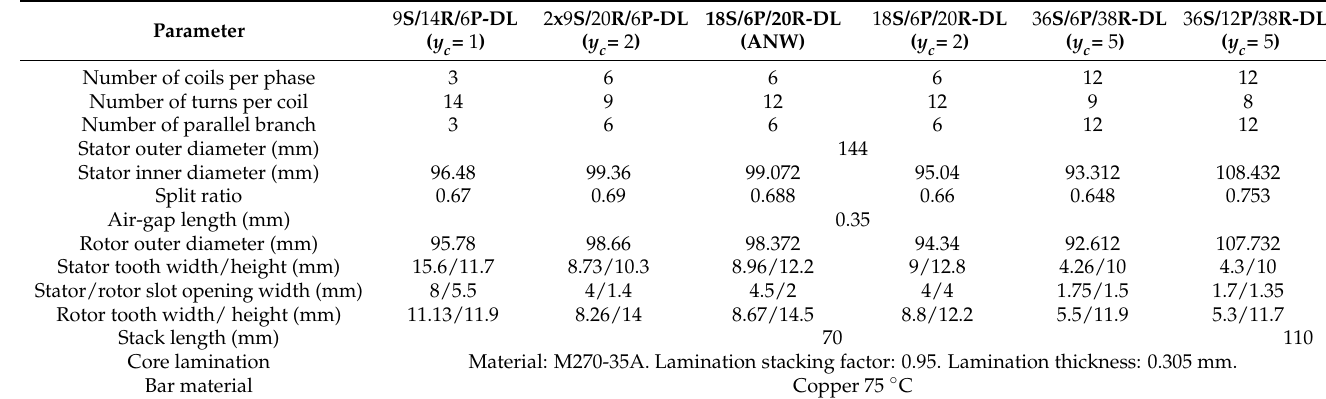
Table A1. Major specifications of the studied